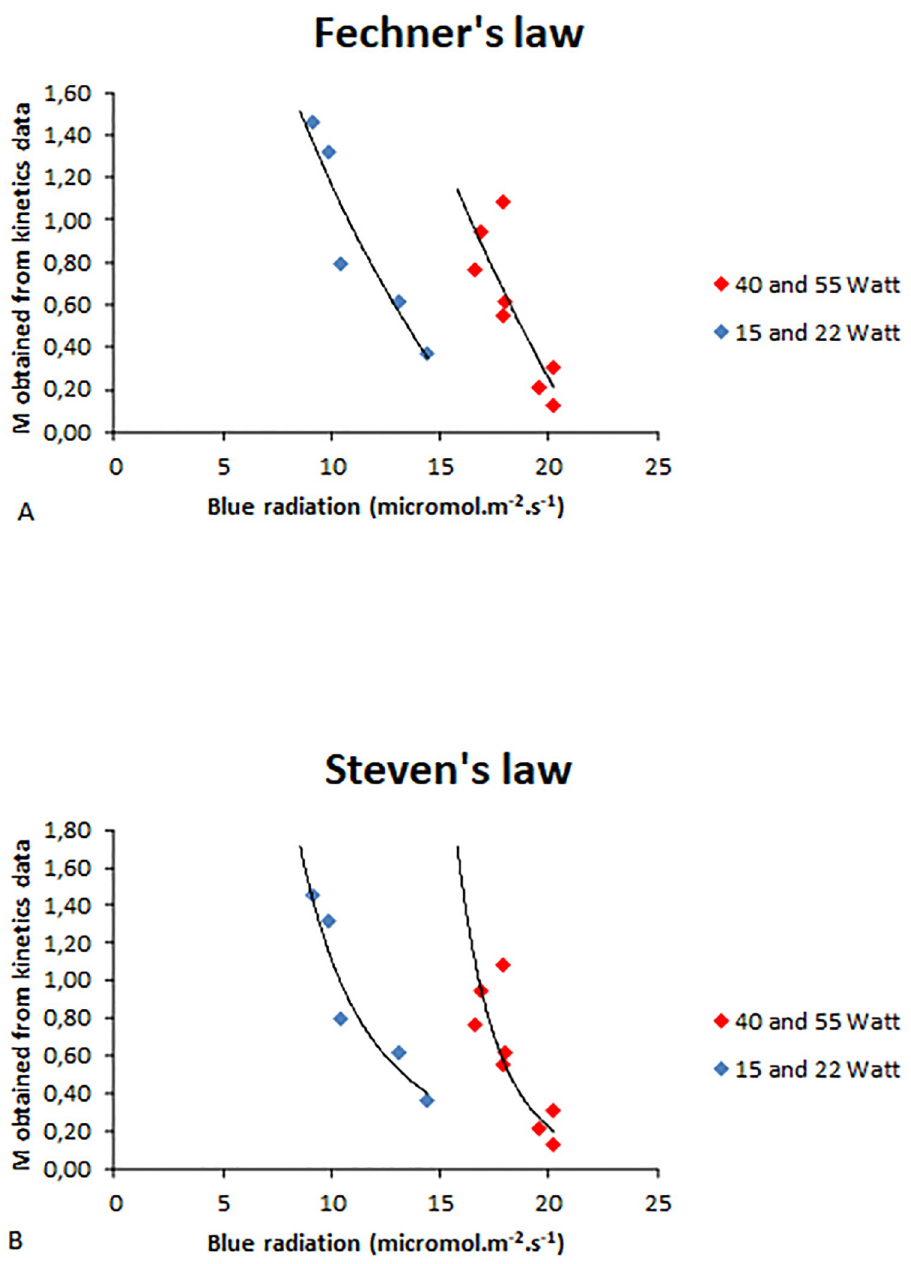
Fig 10. M values (obtained from parameters of the ArC model in kinetics) as a function of blue light intensity for poplar. Blue symbols: data obtained with 15W and 22W neon tubes; Red symbols: data obtained with 40W and 55W neon tubes of. One outlier was removed from the